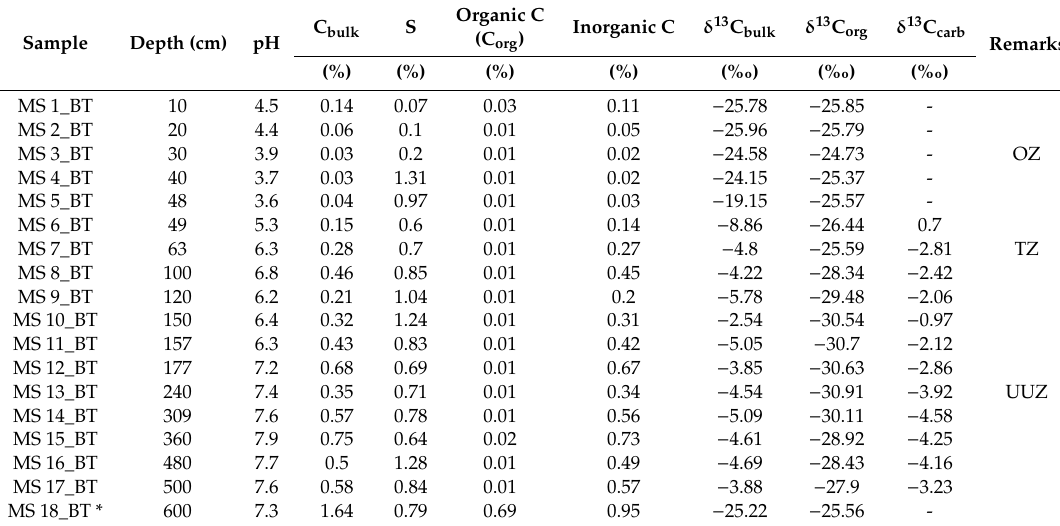
Table 1. Chemical and isotopic ( δ 13 C) composition of the drill core (A1) from the Smaltjärnen tailings at Yxsjöberg. Bulk carbon (C bulk ) and S data are from